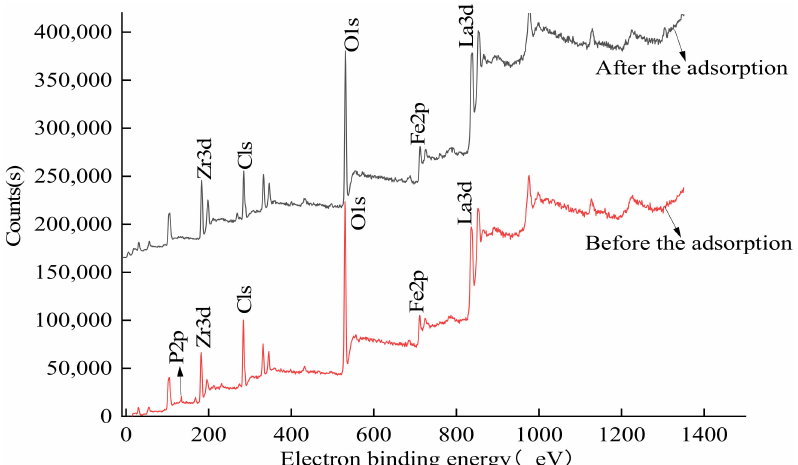
Figure 4. XPS spectra of composite adsorbents.